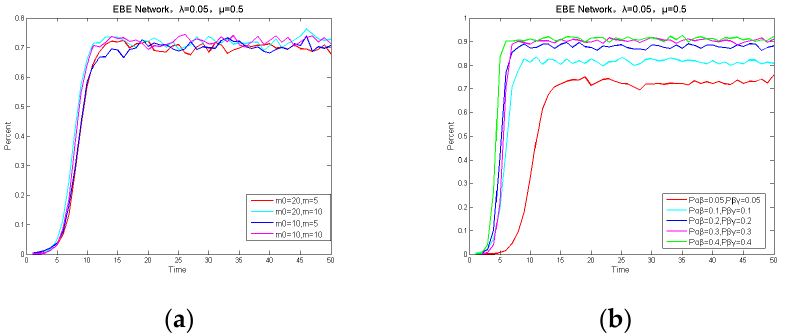
Figure 9. Influence analysis of the three-layer complex network EBE’s parameters on spreading procedure, ( a ) shows the influence of the changing m 0 and m , ( b ) shows the influence of inter-layers link probability.